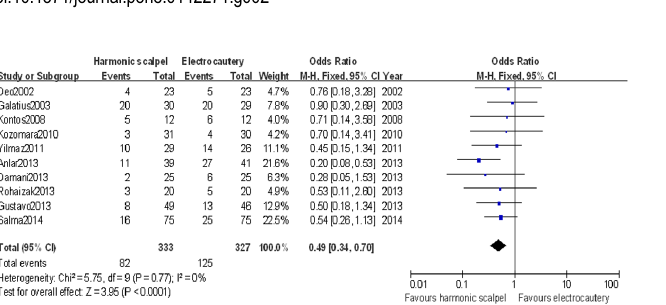
Fig 2. Forest plot for weight mean difference in total postoperative drainage between harmonic scalpel dissection and electrocautery used by random-effect model.